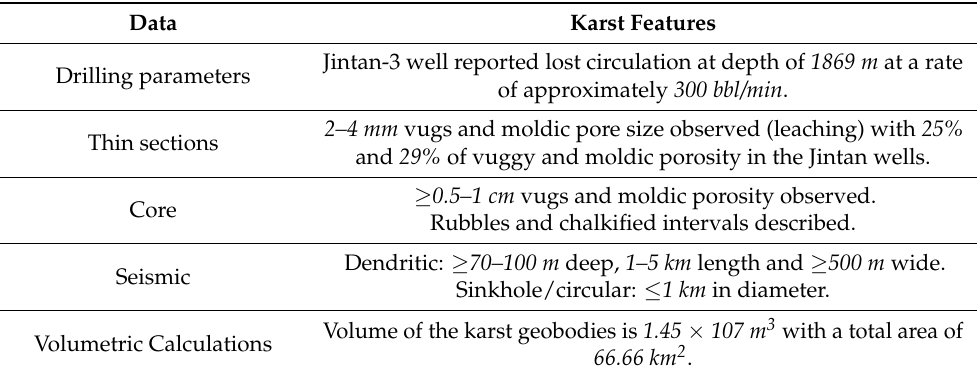
Table 4. Karst features observed on Jintan and M1 fields from the multiscale